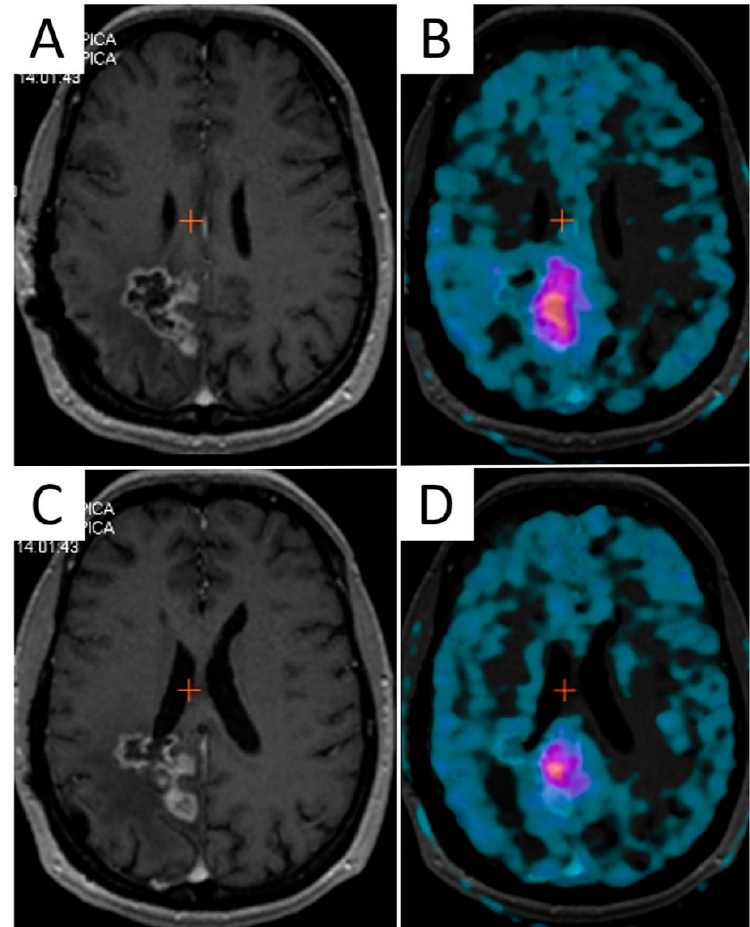
Figure 3. The mismatch between contrast-enhanced T1-weighted MRI and 3,4-dihydroxy-6- [ 18 F]fluoro-L-phenylalanine (F-DOPA) PET/CT in a 45-year-old female patient with recurrent GBM after multimodal first-line therapy. Two axial contrast-enhanced T1-weighted images ( A , C ) along with corresponding F-DOPA PET/CT slices ( B , D ) identifying different volumes of disease.